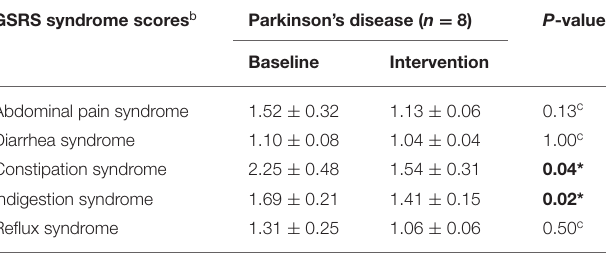
TABLE 2 | Gastrointestinal symptoms at baseline and after a 5-week Mediterranean diet intervention a .